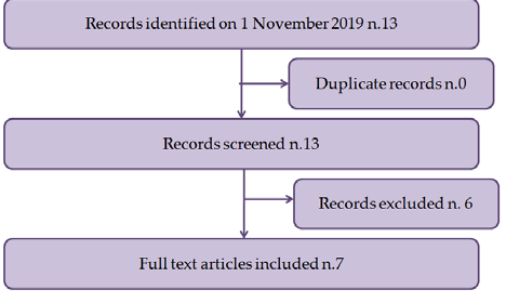
Figure 1. Flow diagram illustrating included and excluded studies in this systematic